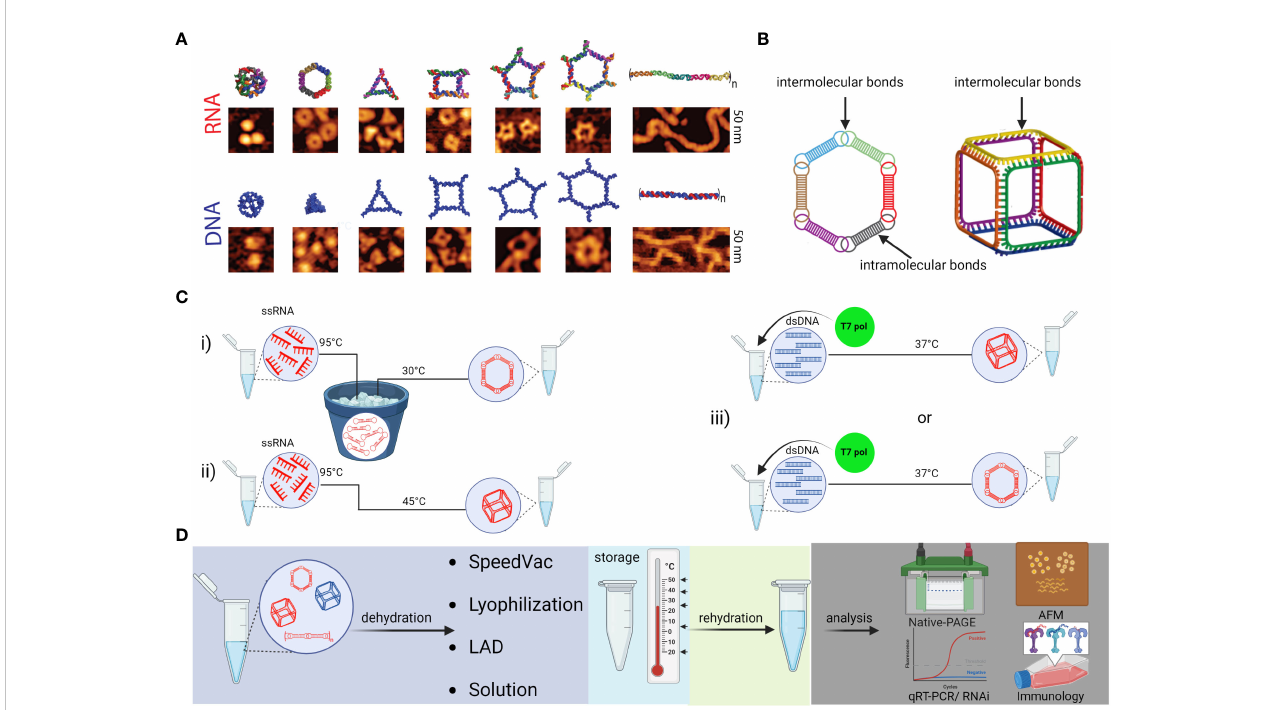
FIGURE 5 Schematic depiction of various NANPs, their production, characterization, storage, and handling. (A) Computational 3D visualization of individual NANPs with corresponding representative AFM images. (B) Two orthogonal NANPs design strategies are based either on the presence of both intra- and intermolecular or only intermolecular bonds, which also determine the assembly protocol of corresponding NANPs. (C) Several protocols for ef fi cient one-pot NANPs self-assembly. Protocol (i) promotes secondary structure formation of individual monomers needed for NANPs assembly via long-range interacting motifs. For this assembly protocol, the individual ssRNAs are fi rst denatured by heating at 95°C and then snap cooled on ice to form intramolecular Watson-Crick (W-C) bonds. The following incubation at 30°C in the presence of Mg 2+ ions allows intermolecular bindings of monomers and assembly of NANPs. In (ii)> protocol, monomers form only intermolecular canonical Watson-Crick base pairs, thus no pre-folding is needed, and any intramolecular interactions should be avoided by design. The (iii) protocol allows for co-transcriptional assembly of different types of NANPs formed as their RNA strands are transcribed from dsDNA templates. (D) Assembled NANPs can be stored and transported in anhydrous forms at ambient temperatures. The impact on structure stability, immunorecognition, and functionality depends of dehydration protocol and needs to be checked after rehydration for each type of